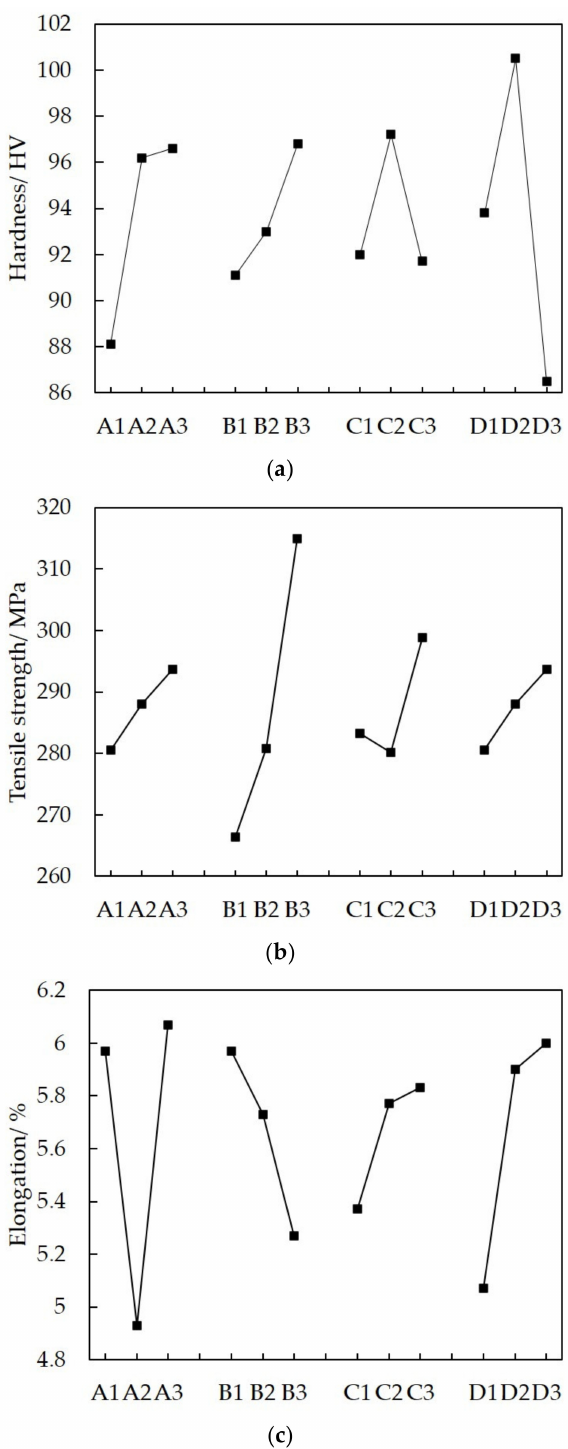
Figure 1. Trend diagram of the impact between the testing indexes and various factors: ( a ) hardness; ( b ) tensile strength; ( c ) elongation. (2) Tensile